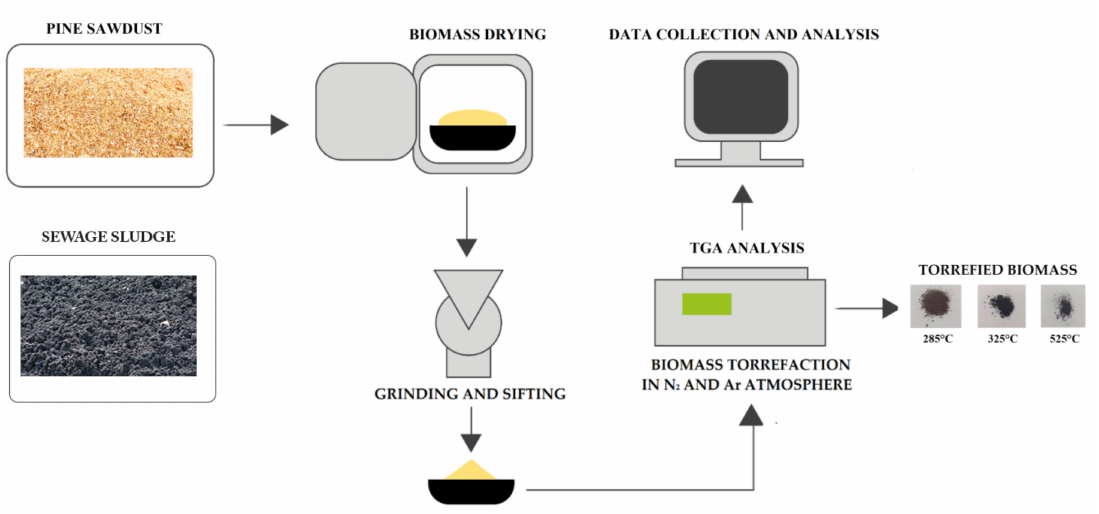
Figure 2. Diagram of an installation for thermogravimetric analysis of pine wood and sewage